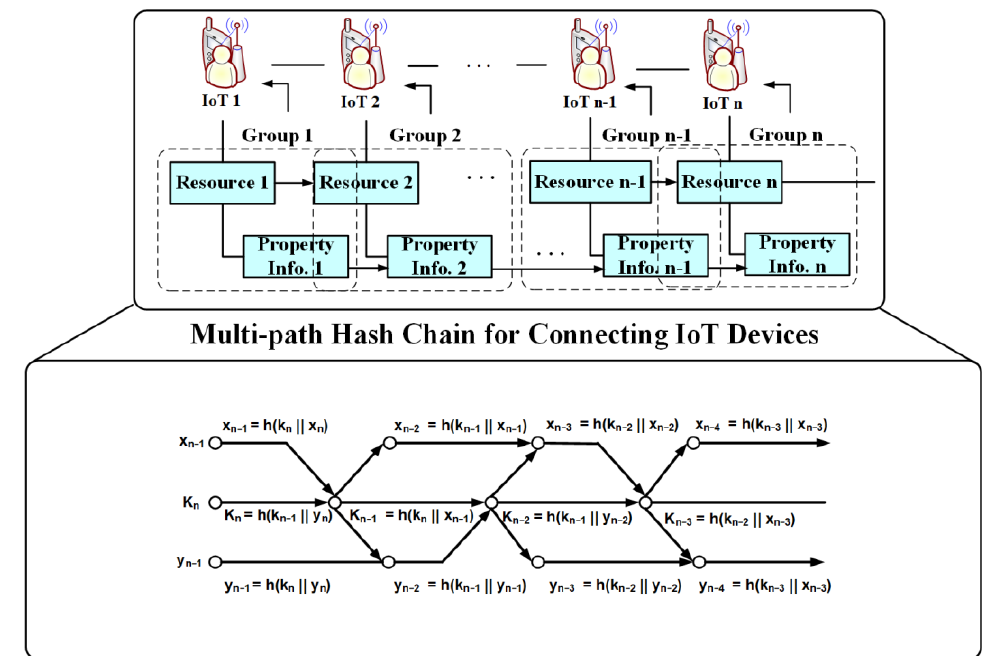
Figure 4. Multi-path hash chain for connecting IoT devices.